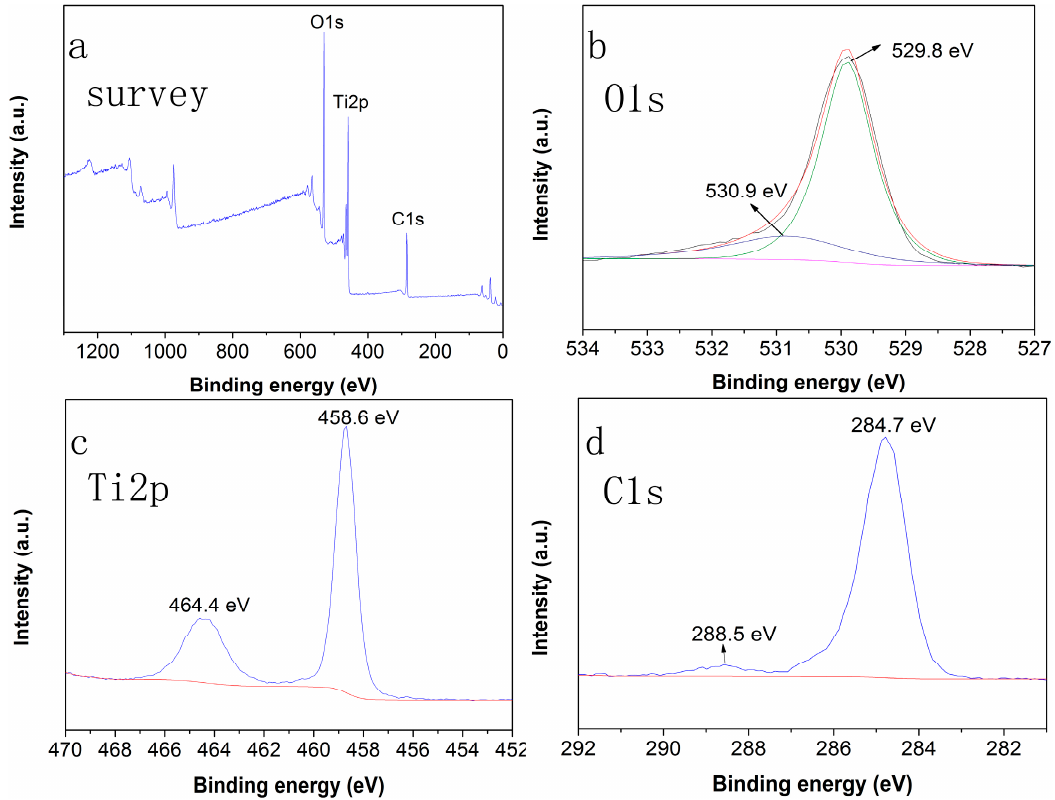
Figure 3. ( a ) XPS spectra of the chlorella/TiO 2 composite; High-resolution XPS spectra of ( b ) C 1s; ( c ) Ti 2p; and ( d ) C